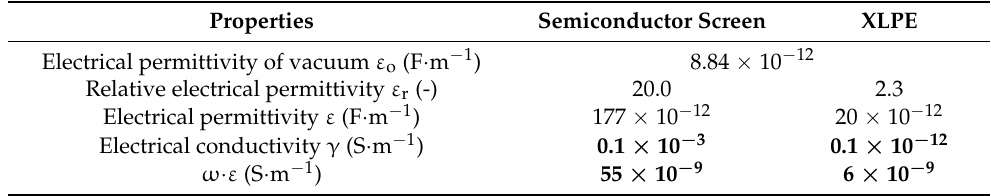
Table 3. Parameters ω · ε and γ for the semiconductor screen and pure XLPE for f = 50